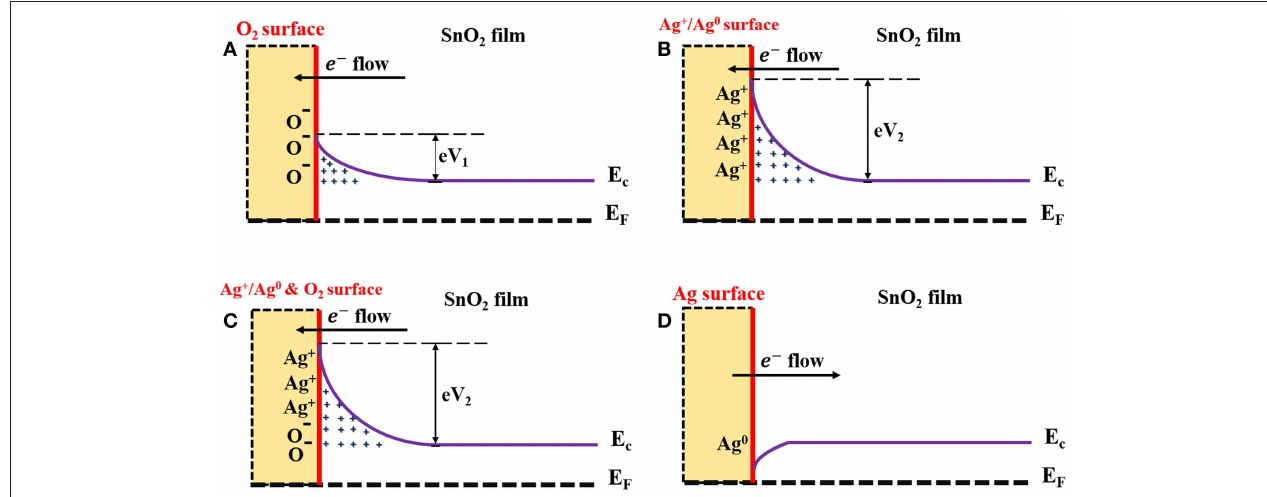
FIGURE 8 | Schematic diagram describes mechanism underlying enhanced H 2 sensing by AgNPs/SnO 2 nanocomposites. (A) Formation of the electrons barrier at the SnO 2 film surface. (B) Formation of the electrons barrier at the AgNPs/SnO 2 film surface. (C) Formation of the electrons barrier at the AgNPs/SnO 2 film surface in the ambient air. (D) Formation of the electrons barrier at the AgNPs/SnO 2 film surface after introducing H 2